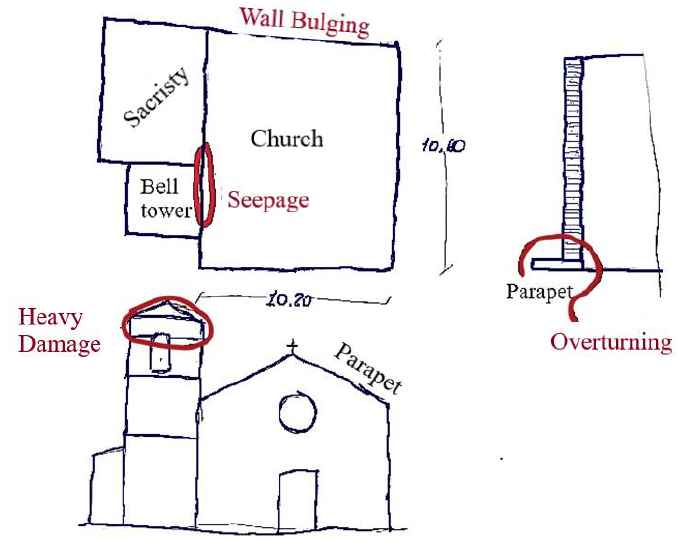
Figure 5. Typical architectural features of the “Apennine church”: the case of the St. Maxim Oratory in Collalto, Amatrice. Sketches made during the inspections.